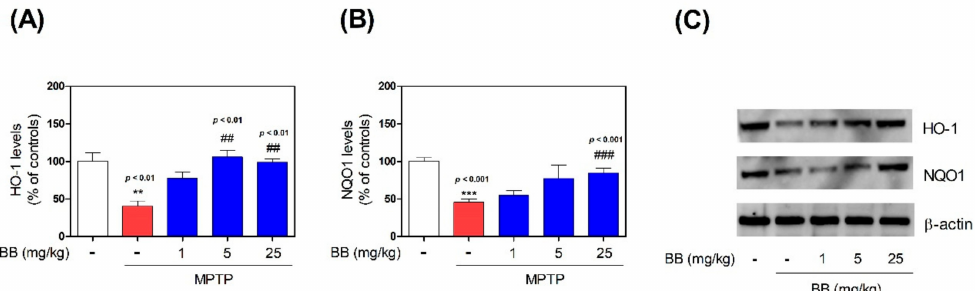
Figure 5. E ff ects of BB on MPTP-induced Heme oxygenase 1 (HO-1) and NAD(P)H dehydrogenase (NQO1) expression. Bar graphs represent the relative proteins expression of HO-1 ( A ) and NQO1 ( B ) adjusted to β -actin expression. The cellular proteins were used for the detection of HO-1 and NQO1 by Western blot ( C ). Values represent means ± S.E.M. ** p < 0.01 and *** p < 0.001 compared with